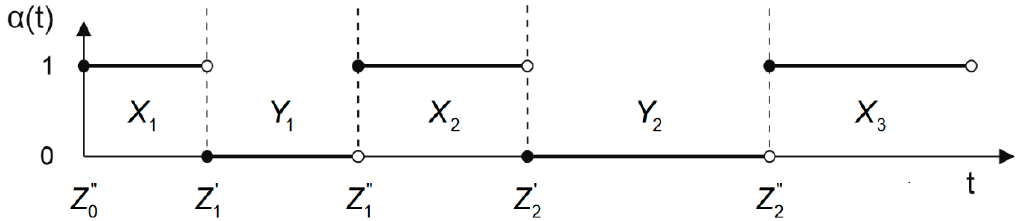
Figure 5. The operational statuses: life (a system’s ability to satisfy the positioning requirements for operation types) and failure (an opposite event). Own study based on: [40].